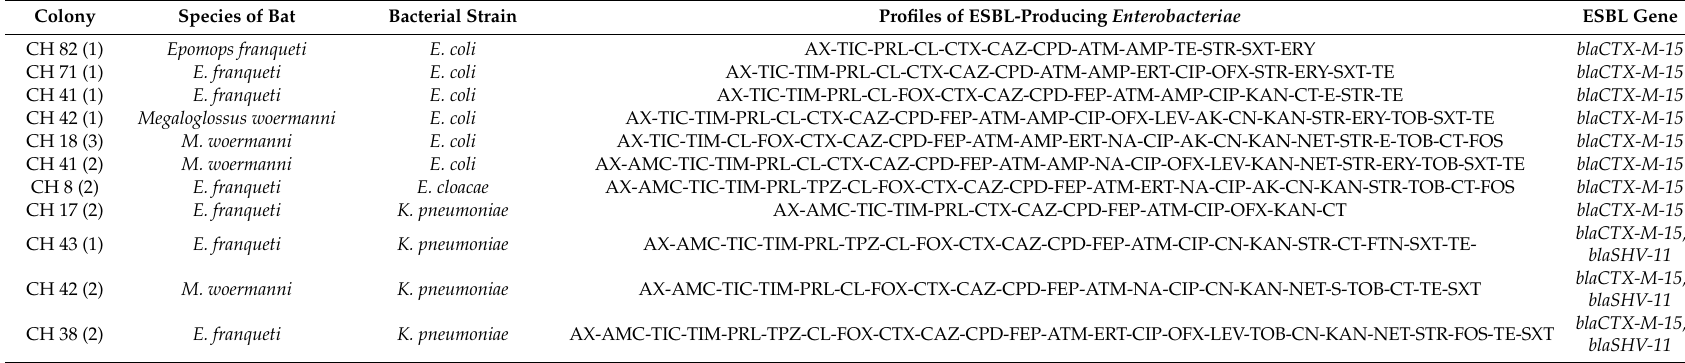
Table 4. Antibiotic resistance profiles of Extended spectrum Beta-lactamase (ESBL)-producing Enterobacteriae from bats belonging to the family of Pteropodidae.